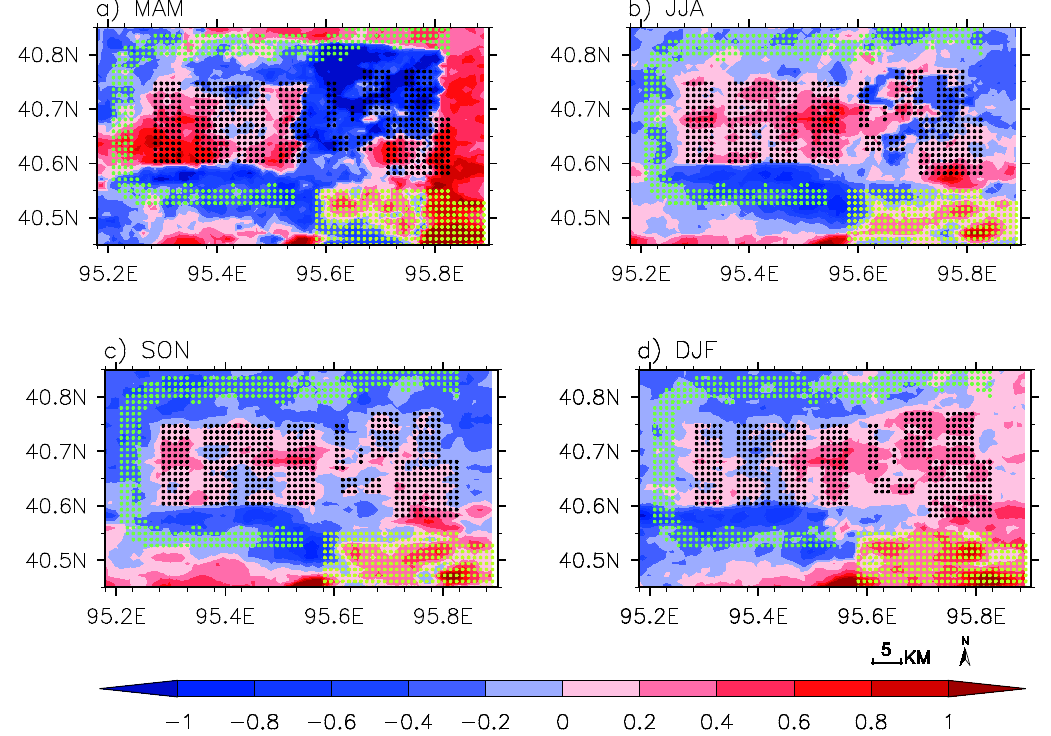
Figure 4. MODIS night-time LST differences between the post-turbine-construction years (2010–2012) and pre-turbine-construction years (2005–2007) in ( a ) spring; ( b ) summer; ( c ) autumn; and ( d ) winter. Black dots represent the wind farm pixels, cyan dots refer to the NNWF pixels and yellow dots indicate the center of Guazhou county pixels.